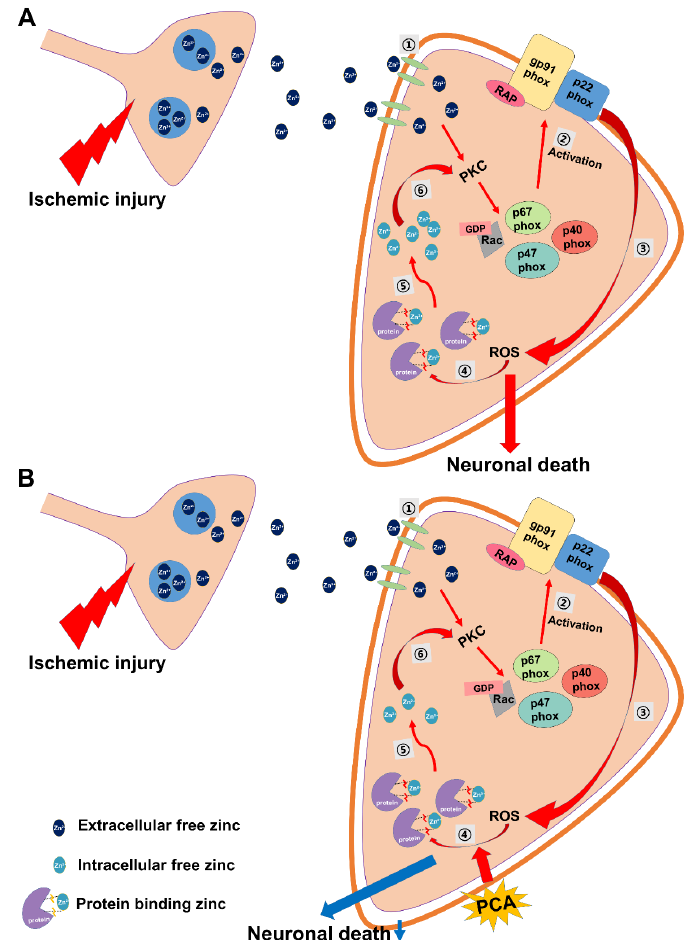
Figure 9. Possible association of zinc, PCA and neuronal death under ischemic conditions. This schematic illustration demonstrates neuronal death by ischemic-induced zinc release. ( A ) (1) Zinc is released into the intracellular space through zinc receptors. (2) PKC and p47 activation and NADPH oxidase activation. (3) Increased ROS formation. (4) ROS inhibits protein zinc binding. (5) Increase of intracellular free zinc. (6) Exacerbated neuronal death by increased intracellular free zinc. When these conditions dominate neuronal death is more likely to occur. ( B ) However, administration of PCA can reduce the intracellular free zinc level by scavenging ROS and thus decrease ischemia-induced neuronal